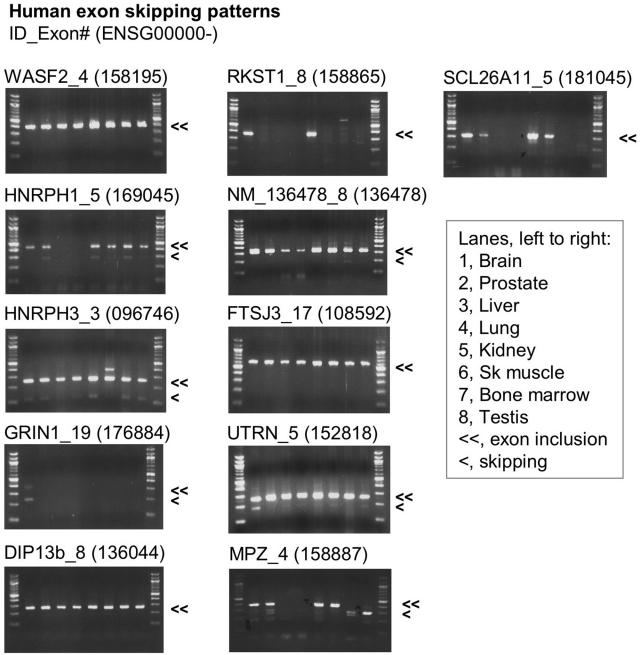
RT-PCR Confirmation of Exon Skipping Patterns in Human TissuesEleven orthologous exons (≤250 nucleotides in length) were selected from the analysis of Figure 5 for RT-PCR analysis in a panel of eight human tissues. These exons are derived from the intersection dataset, in which conserved
TAGG and
GGGG motifs are present in combination in the human and mouse orthologous exons. Additional cDNA and EST evidence for these skipping events are summarized in Table 1. Specific primer pairs were designed for each test exon to amplify the exon-included (double arrowhead) and exon-skipped (single arrowhead) products by RT-PCR. Each gel panel shows the products of reactions for a single test exon resolved on agarose gels in the arrangement given in the inset. Gene name, exon number, and Ensembl number (in parentheses) are provided above each gel panel. The far left and far right lanes of each gel panel contain DNA molecular weight markers.